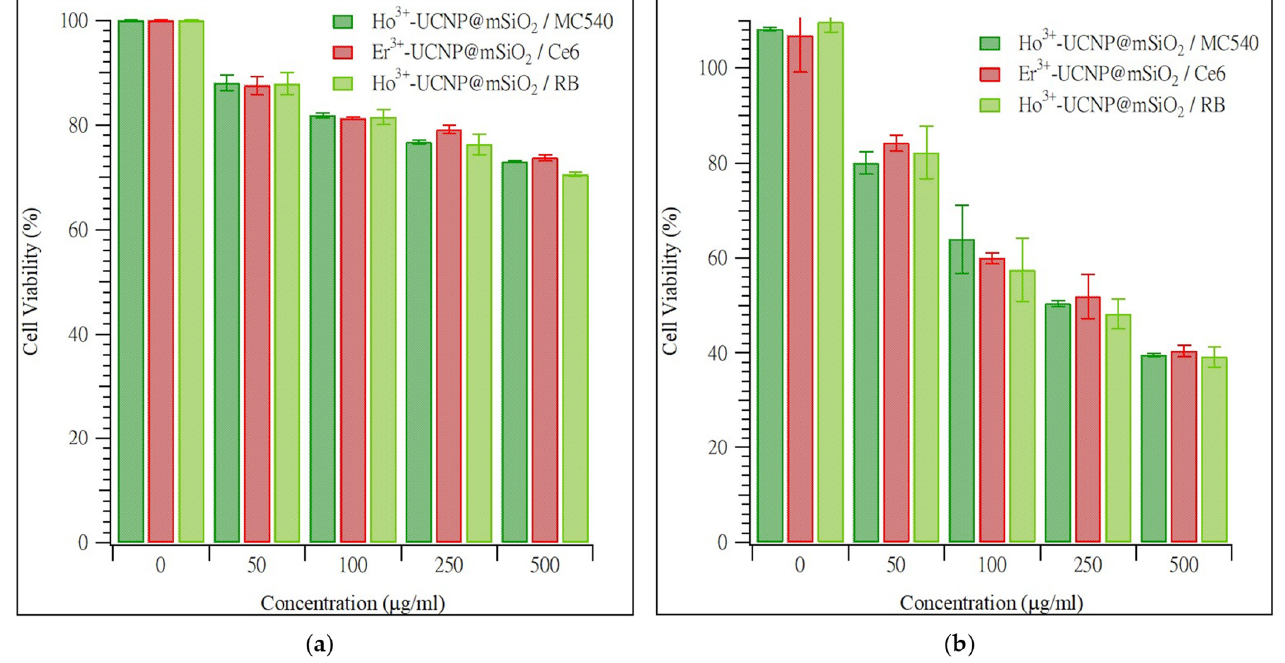
Figure 9. ( a ) Viability of MCF-7 cells incubated with UCNP@mSiO 2 /PS at different concentrations for 24 h without NIR exposure. ( b ) Viability of MCF-7 cells incubated with UCNP@mSiO 2 /PS at different concentrations for 24 h and irradiation with 980 nm for 5 min.